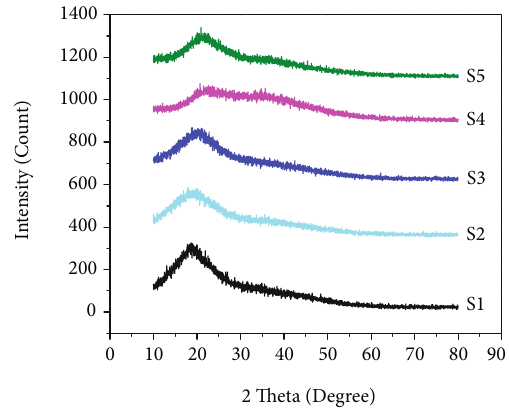
Figure 3: X-ray di ff raction patterns of PUL-CMC blend fi lms (S1-